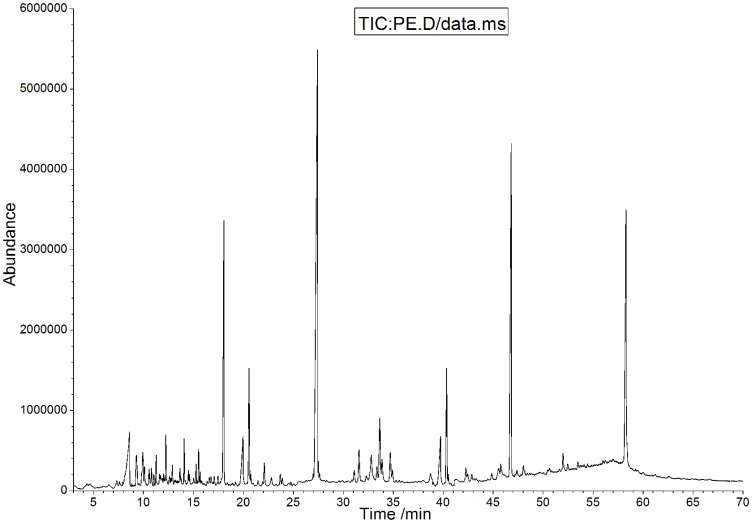
The total ion chromatogram of volatile constituents in the PE fraction.